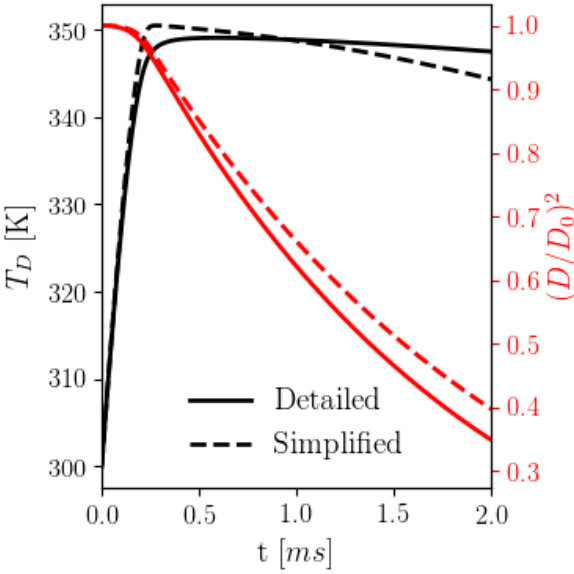
Figure 14. Temporal evolution of the droplet temperature, left axis, and the normalized surface area, right axis, for the detailed model (solid lines), and semi-empirical model (dashed lines). Results are shown for R D = 20 µ m , I L 0 = 10 10 W/m 2 for the continuous laser heating